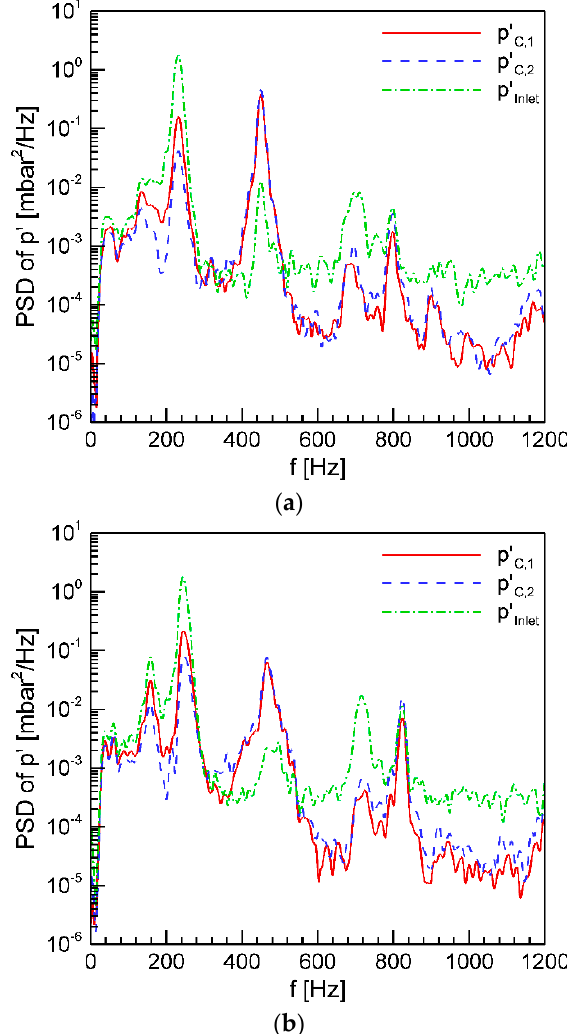
Figure 10. Power spectral densities of the filtered pressure fluctuations using C 2 H 4 at L C = 895 mm, SN = 0.46, and u = 10 m/s: ( a ) ϕ = 0.70 and ( b ) ϕ = 0.75.